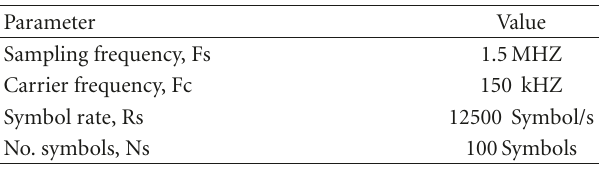
Table 1: Modulation